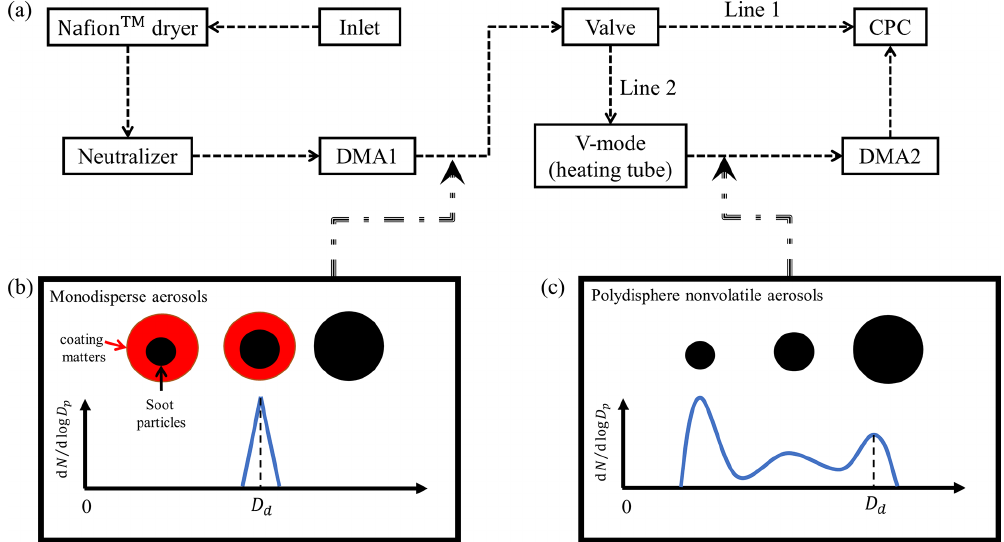
Figure 1. Schematic diagram of the volatility tandem differential mobility analyzer used in this